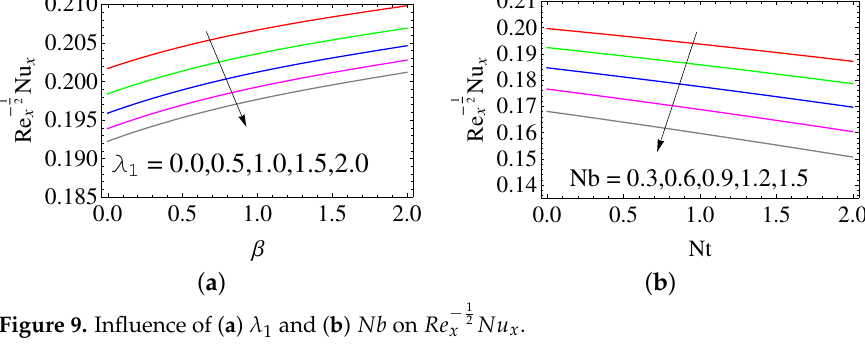
Figure 9. Influence of ( a ) λ 1 and ( b ) Nb on Re